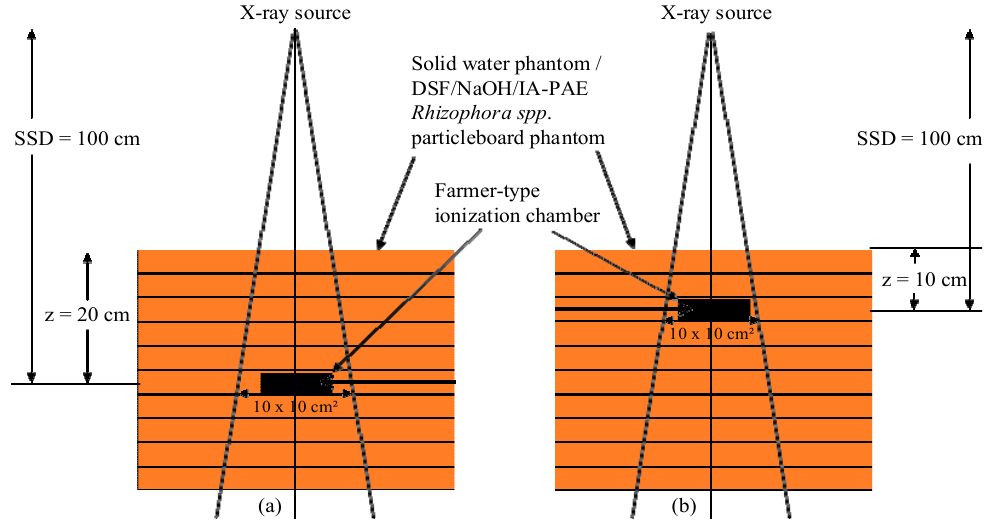
Figure 2. Measurement setup for TPR 20,10 : ( a ) depths z = 20 cm and ( b ) depth z = 10 cm below the water surface at field size (10 cm × 10 cm) and SSD (100 cm).